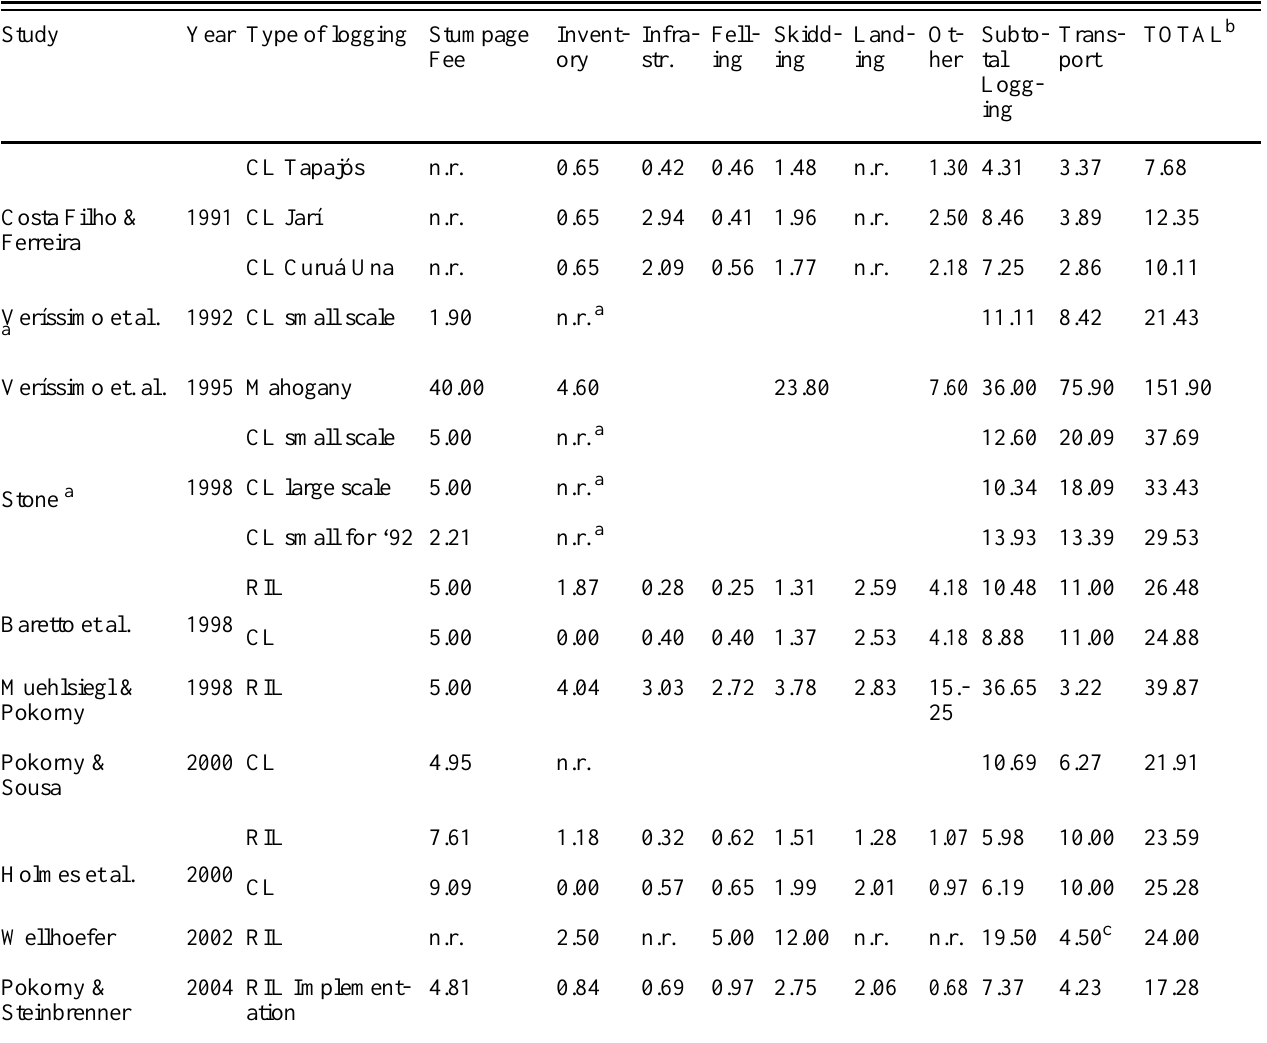
Table 2 . Harvest and transport costs (US$/m³) in selected studies.